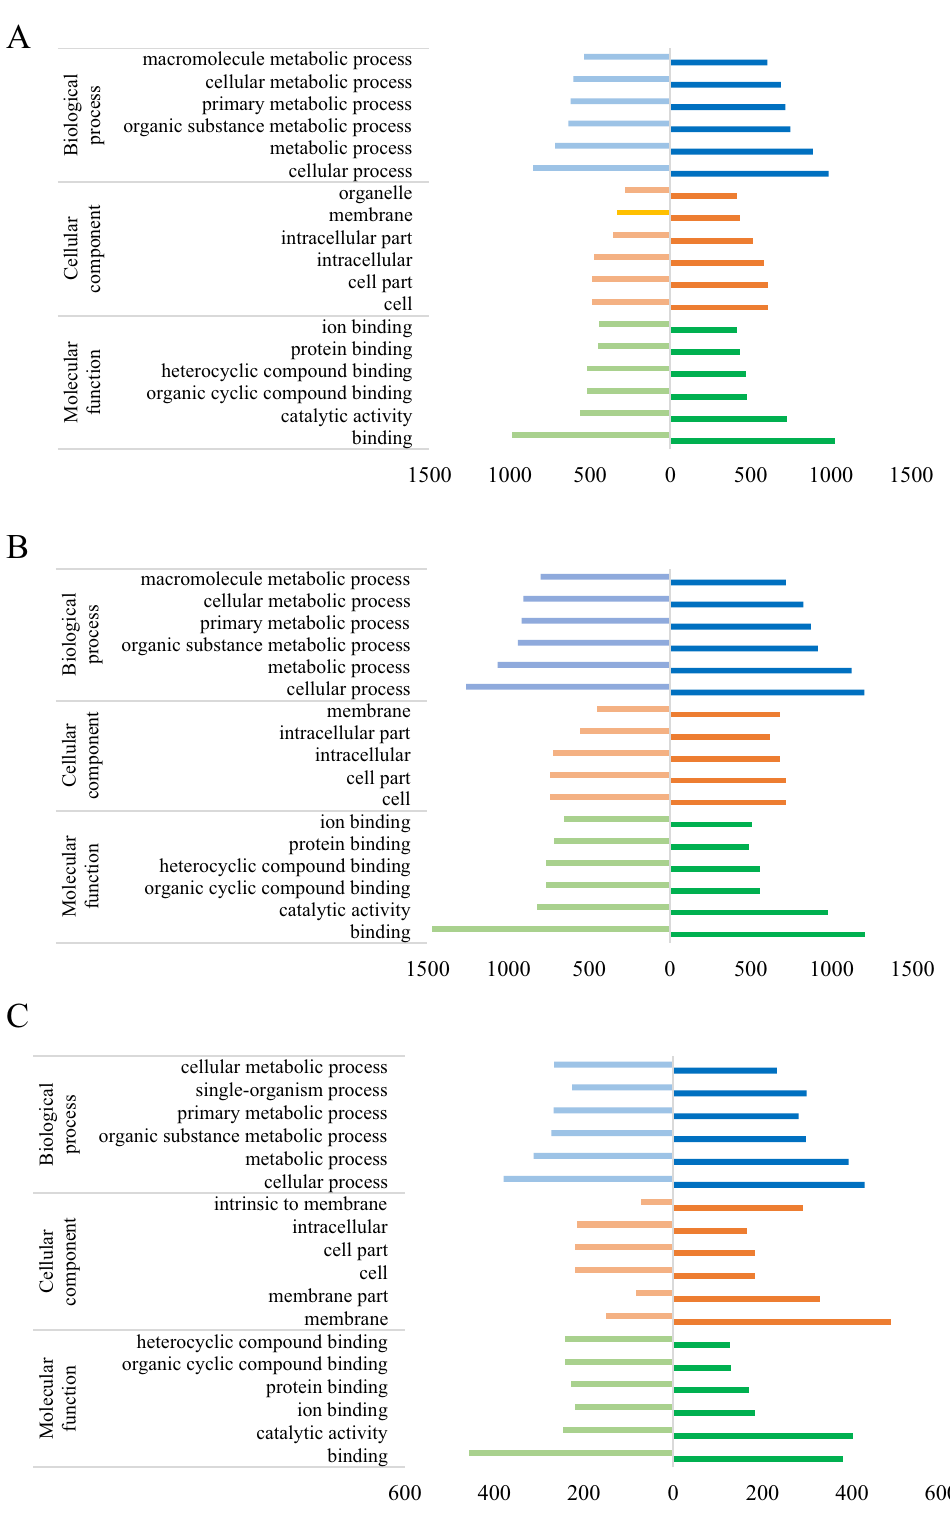
Fig. 5 GO-based functional enrichment analysis of DEGs in ( A ) UVB/Control, ( B ) UVB-JTE/Control, and ( C ) UVB-JTE/UVB, respectively. Bar charts indicate the number of DEGs that were up- (right of X-axis) and down-regulated (left of X-axis), annotated with functions